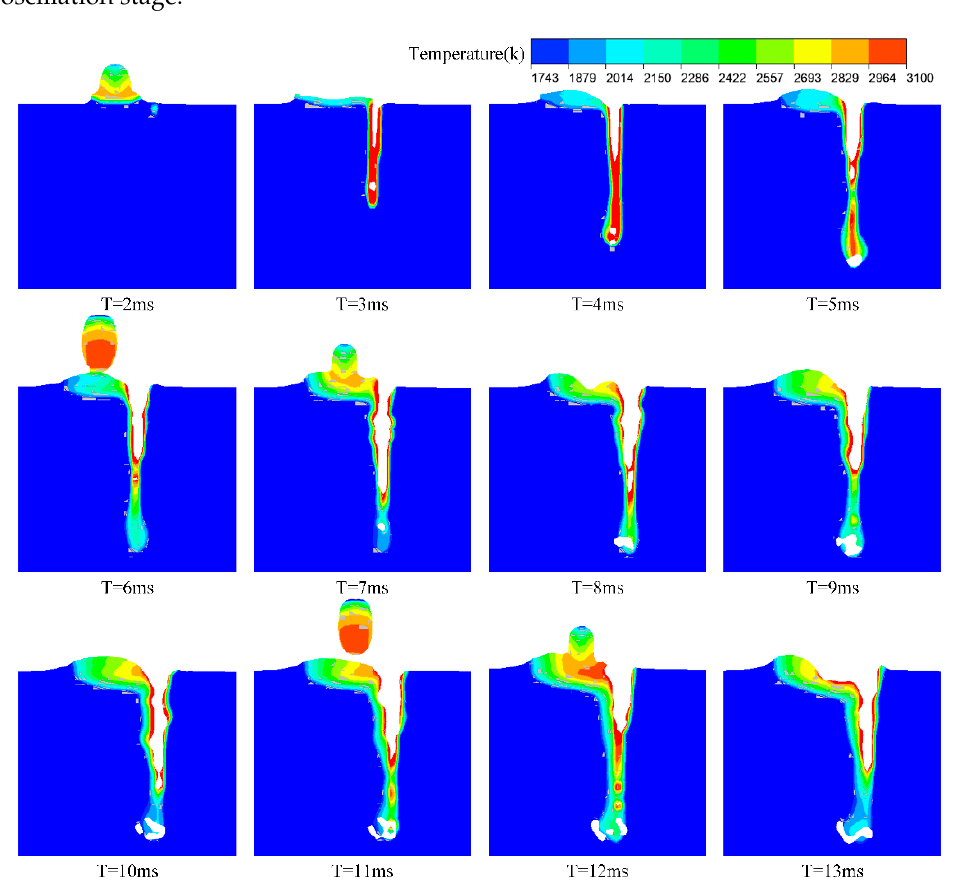
Figure 12. Keyhole evolution at laser power 7.5 kW.